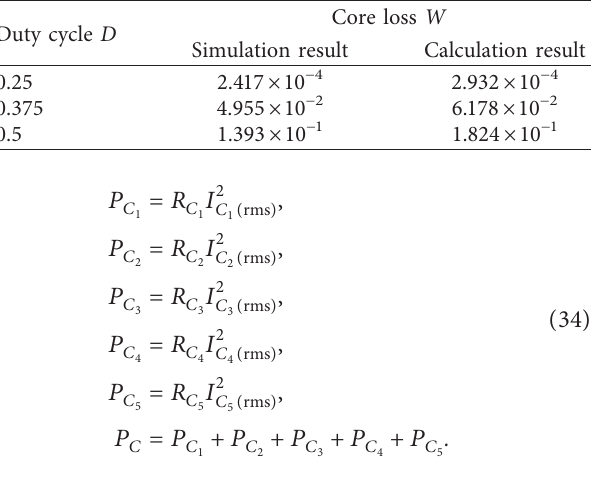
Table 4: Core loss